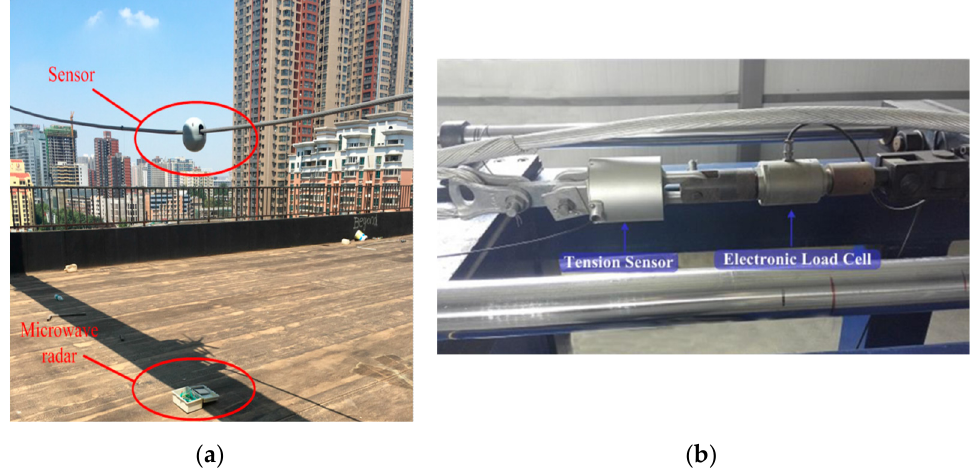
Figure 3. Installation mode of original monitoring system. ( a ) The monitoring terminal is installed on the wire [12]; ( b ) The sensor is mounted on the wire [20].